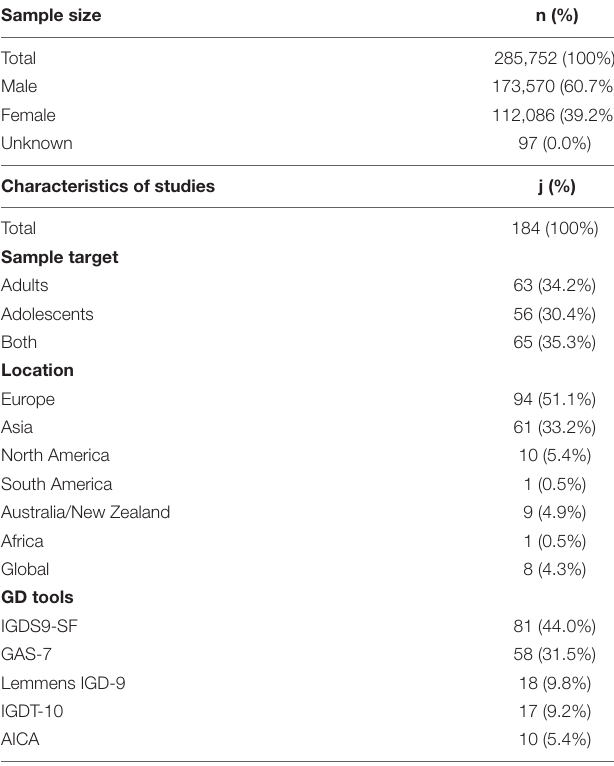
TABLE 1 | Key characteristics of the included studies for quantitative